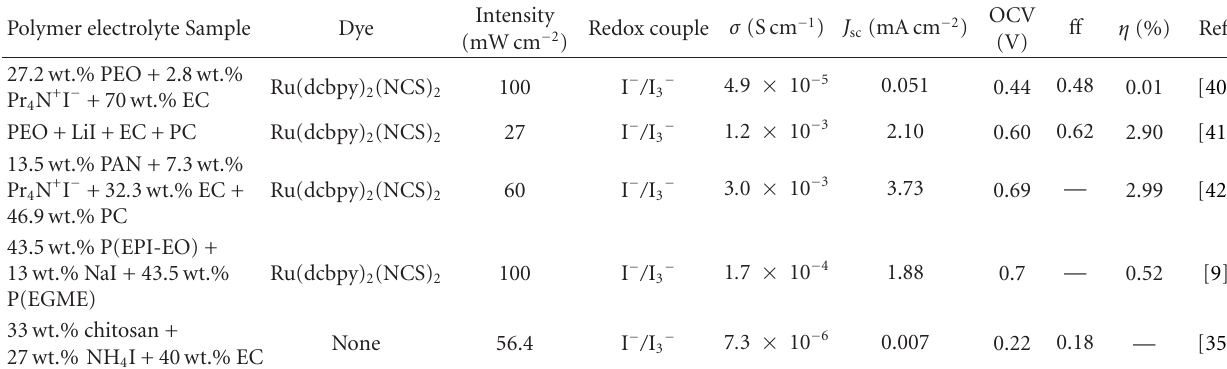
Table 3: Characteristics of PEC cells using plasticized polymer-salt systems. Polymer electrolyte Sample